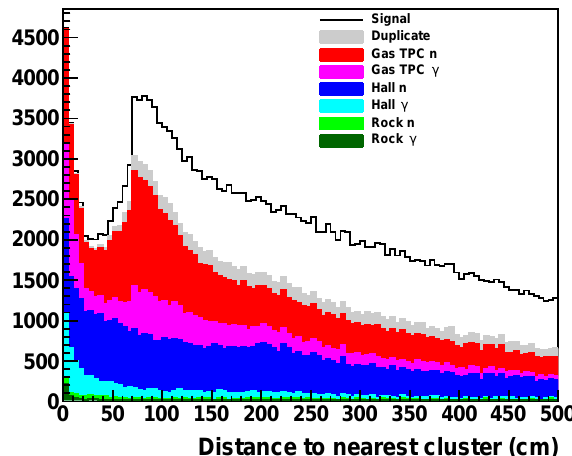
Figure 82. The distribution of the closest distance of the candidate cluster to any other isolated cluster for RHC mode. A cut is made at